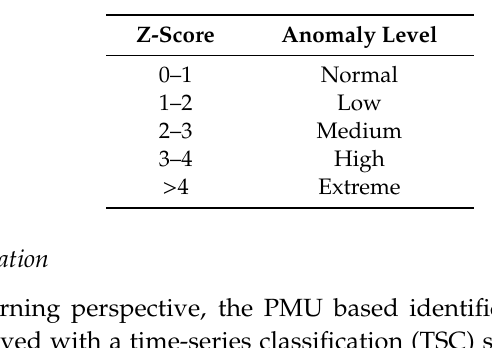
Table 4. Overview z-scores and corresponding anomaly